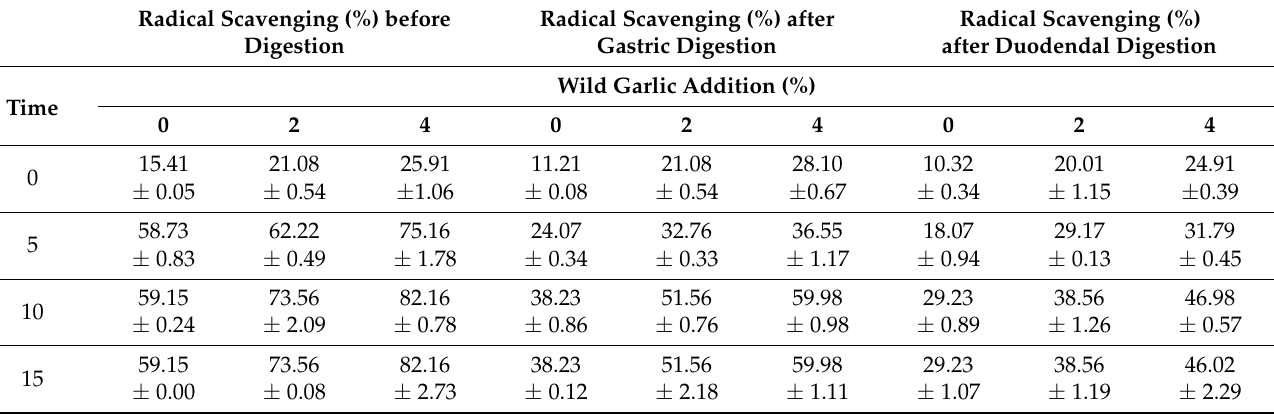
Table 7. DPPH radical scavenging activity of corn snacks enriched with wild garlic before and after two-stage digestion (n = 3; mean ±